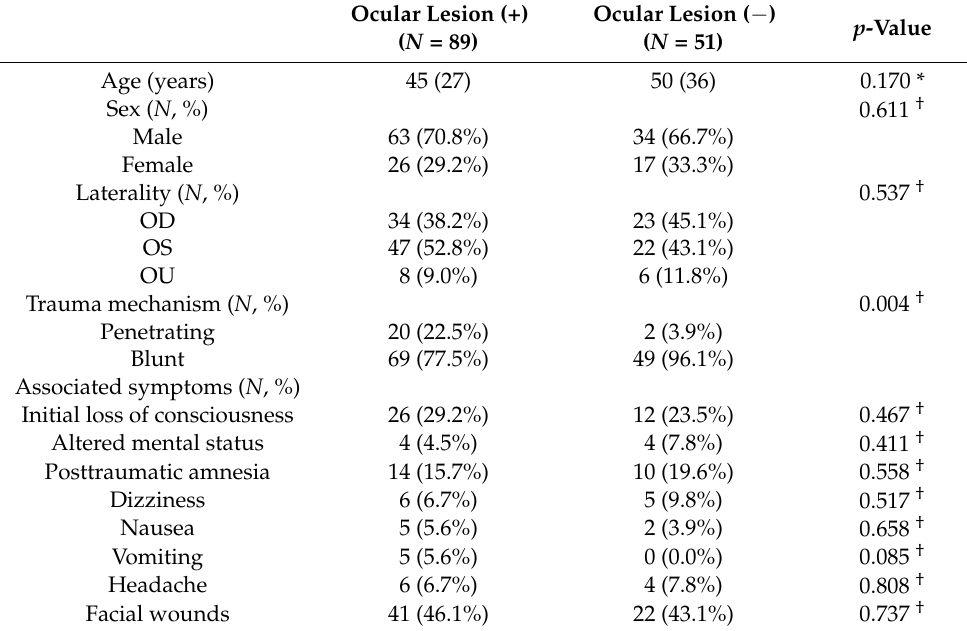
Table 1. Characteristics of head injury patients who underwent an ophthalmology consultation in the emergency department ( N = 140).